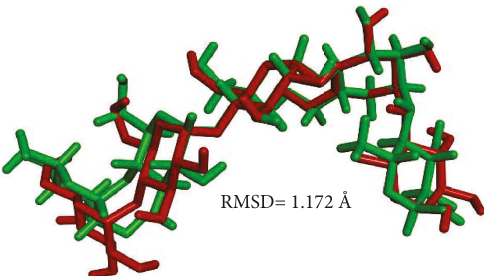
Figure 6: Validation docking test results. Cocrystalized ligand (native ligand) is in green color, redocked ligand is in red